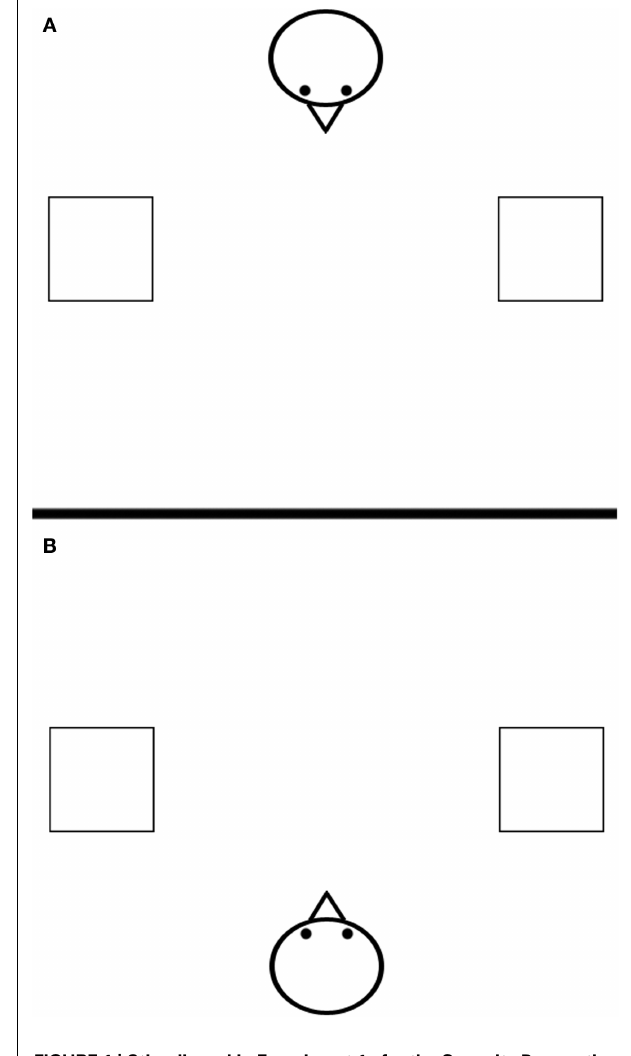
FIGURE 1 | Stimuli used in Experiment 1a for the Opposite Perspective condition [(A), top] and the Shared Perspective condition [(B), bottom]